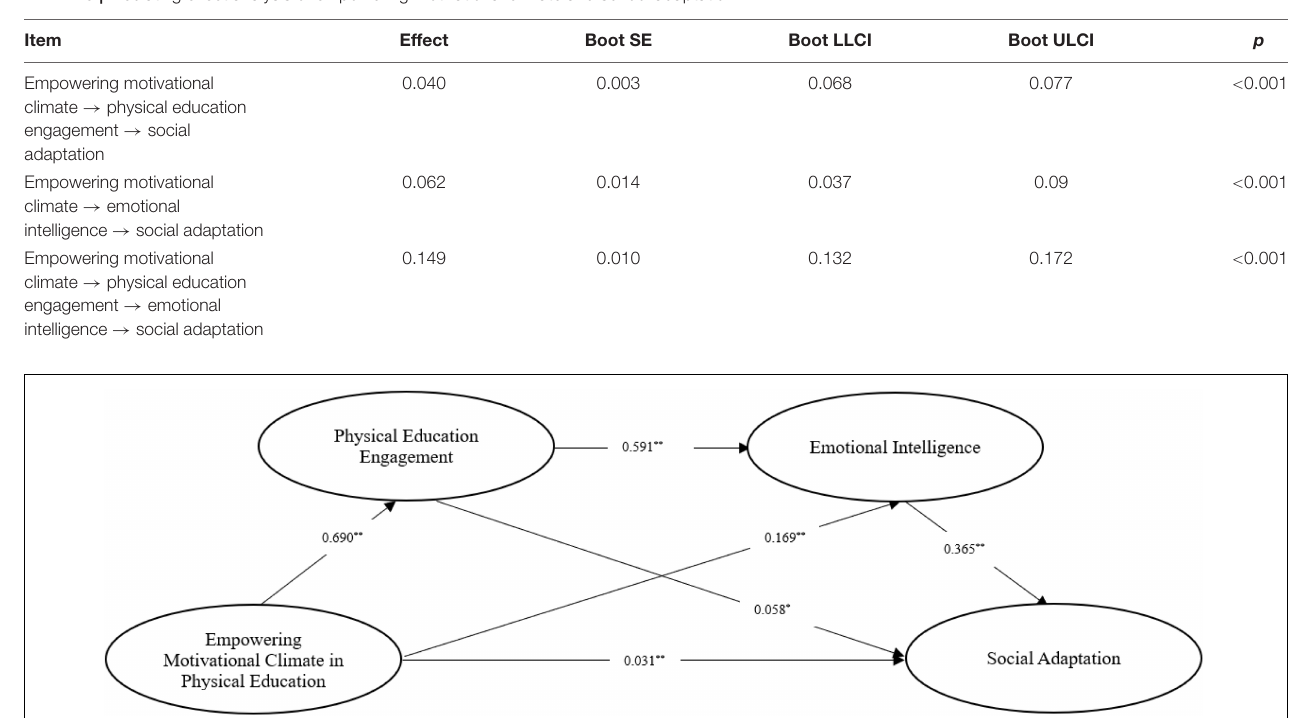
TABLE 3 | Mediating effect analysis of empowering motivational climate and school adaptation.